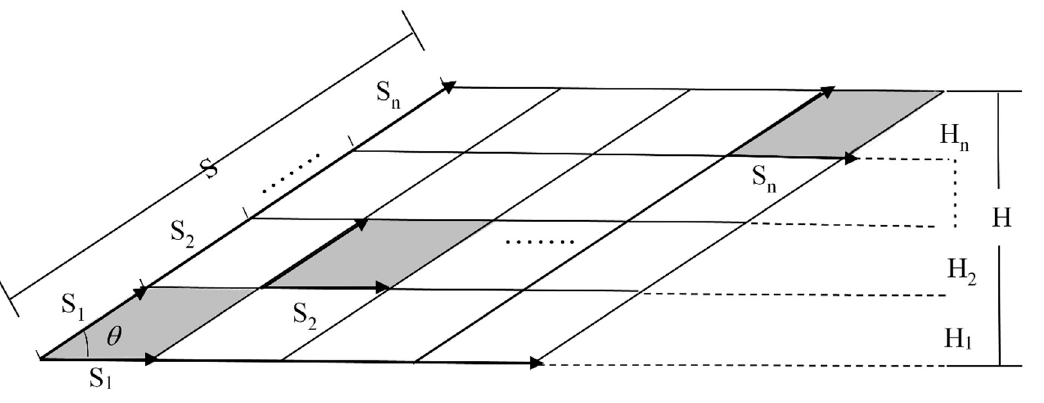
Figure 5. Schematic slant path transmission.